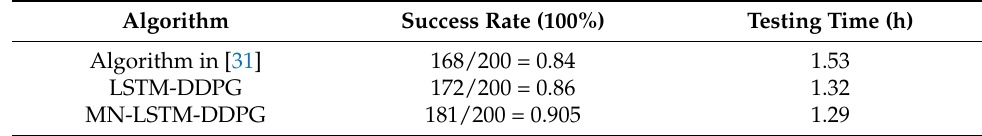
Table 6. Comparison of test results of the improved algorithm in simulation Figure